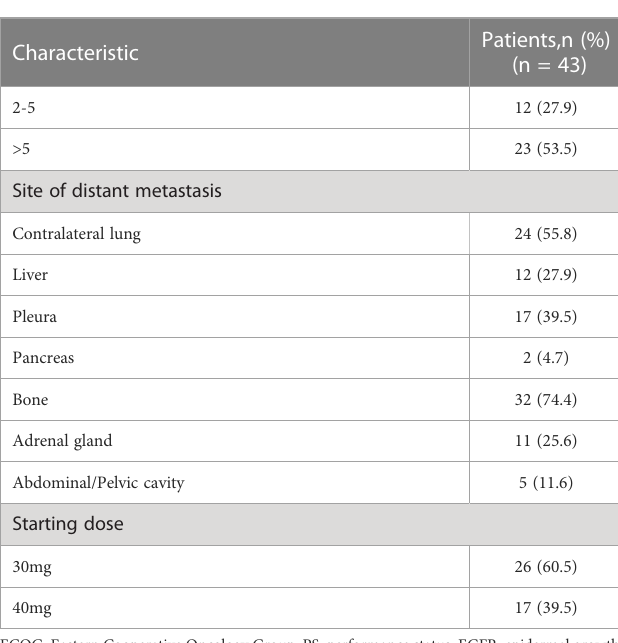
CI, 1.3 - 2.0 months), which were the same as the cEFR set. The baseline neurological symptoms in 4 patients were obviously improved after starting afatinib. In the subgroup analysis strati fi ed by EGFR mutation subtypes, as shown in Table 3, patients with common mutations (n = 13) achieved a signi fi cantly higher CNS ORR than those with uncommon mutations (n = 10) in the cEFR set (13 of 13 [100.0%] vs 6 of 10 [60.0%]; p = 0.024), as well as numerically higher CNS ORR in the cFAS set, though without statistical signi fi cance (15 of 26 [57.7%] vs 6 of 17 [35.3%]; p = 0.151). CNS mPFS was signi fi cantly longer in the common mutation group than the uncommon mutation group (14.4